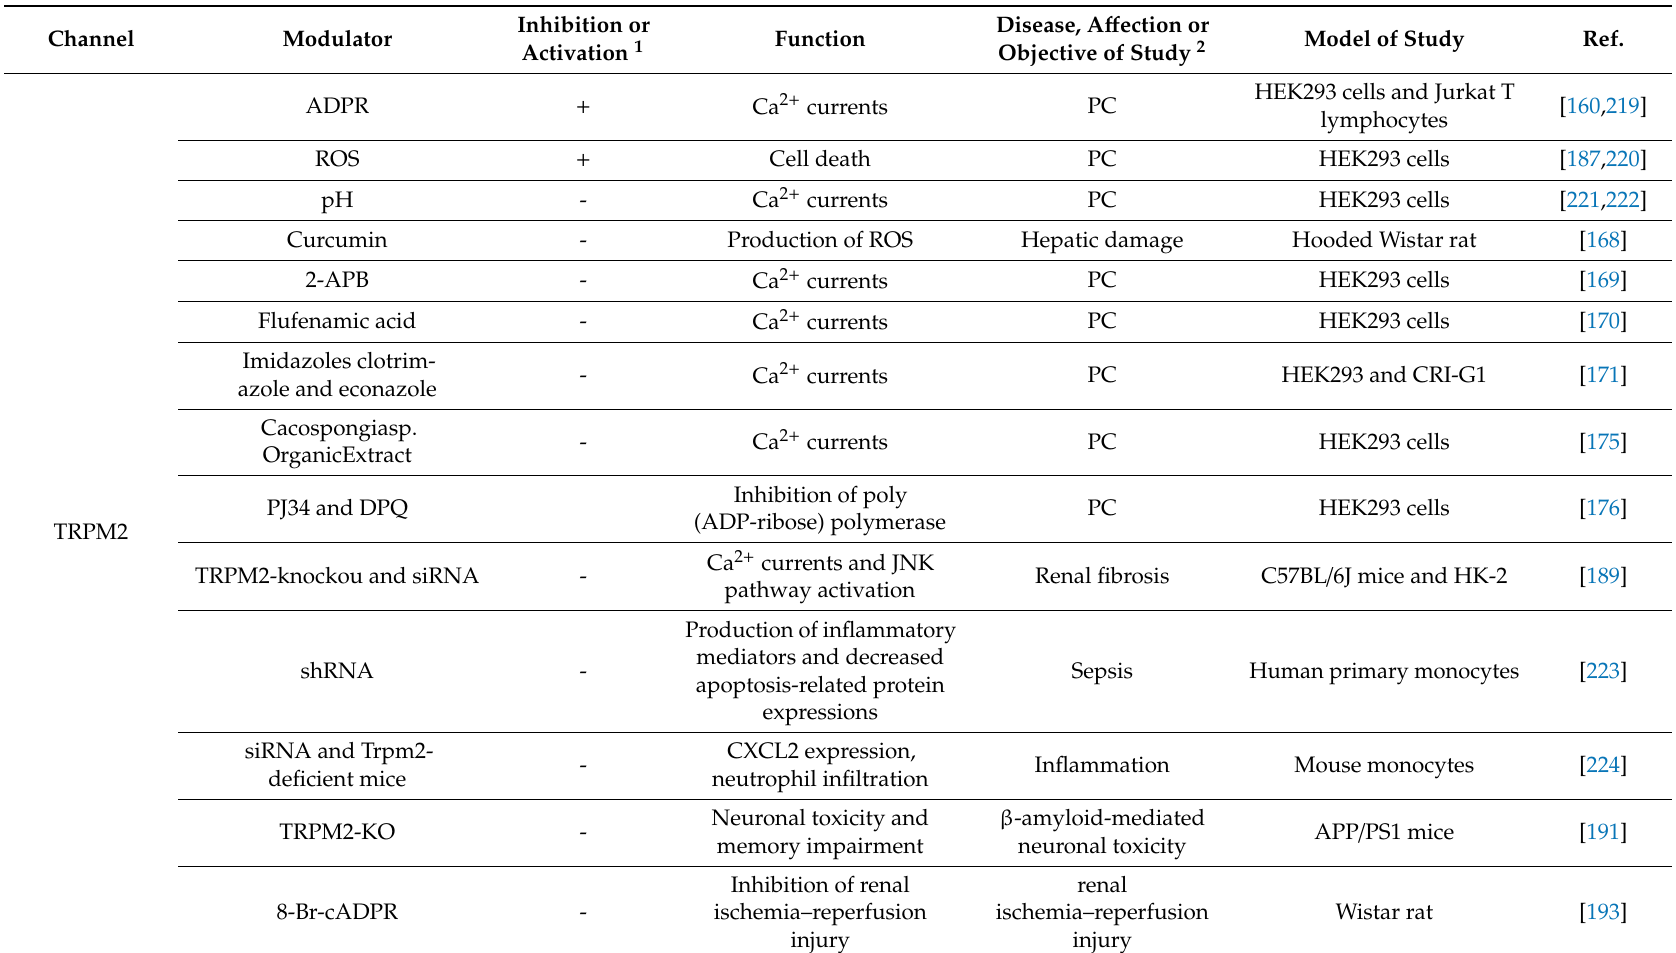
Table 2. Molecules modulating the activity of TRPM2 and TRPM8, participation in physiological processes and